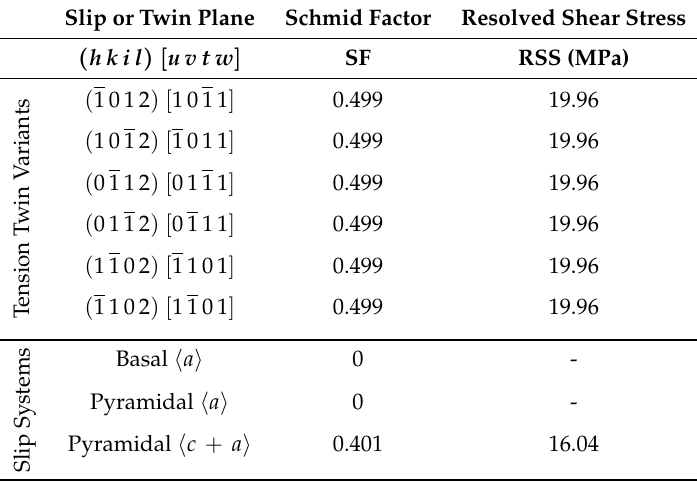
Table 1. Values of resolved shear stress and Schmid factors determined by [ 0001 ] loading with applied stress at yield of ET-Tension in Figure 2. Slip or Twin Plane Schmid Factor